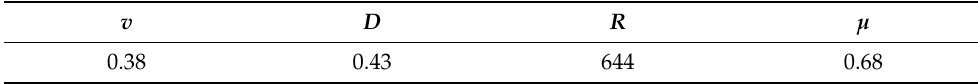
Figure 10. Predicted breakthrough curve for an inflow TC concentration of 100 µ g L − 1 . Table 5. Hydrodynamic parameters chosen for the prediction at 100 µ g L − 1